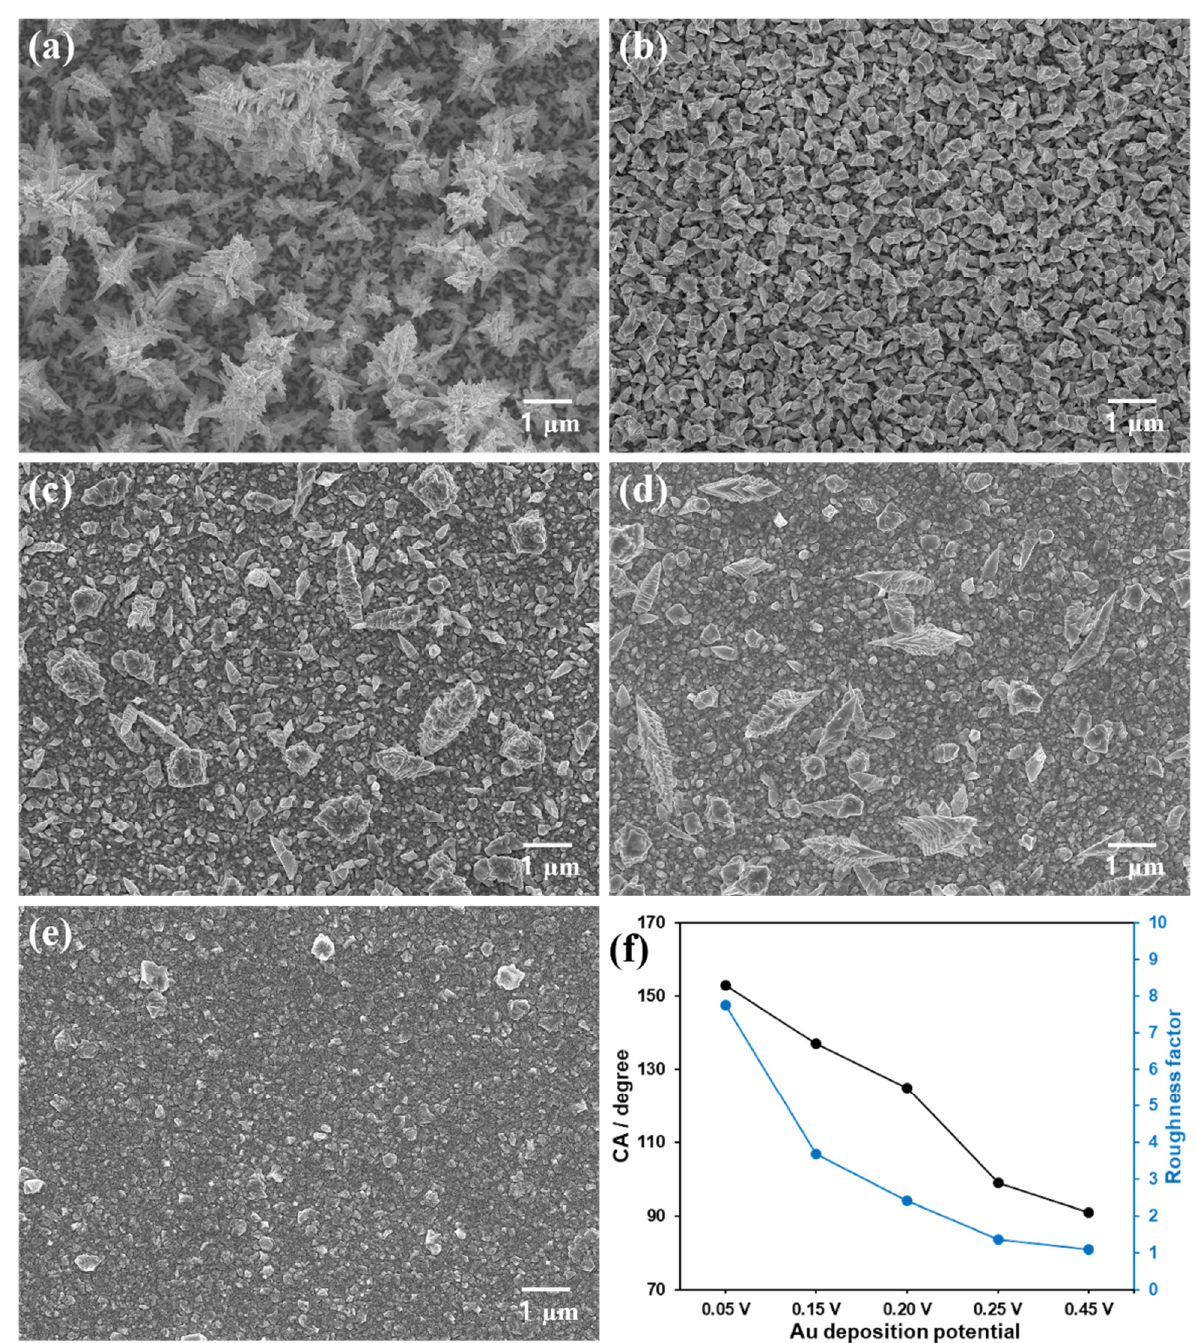
Figure 1. ( a – e ) SEM images of the Au nanostructures electrodeposited with various applied potentials of ( a ) 0.05 V, ( b ) 0.15 V, ( c ) 0.20 V, ( d ) 0.25 V and ( e ) 0.45 V vs. Ag/AgCl. ( f ) Static water contact angles and roughness factors of the Au surfaces as a function of the deposition potential ( n = 5).